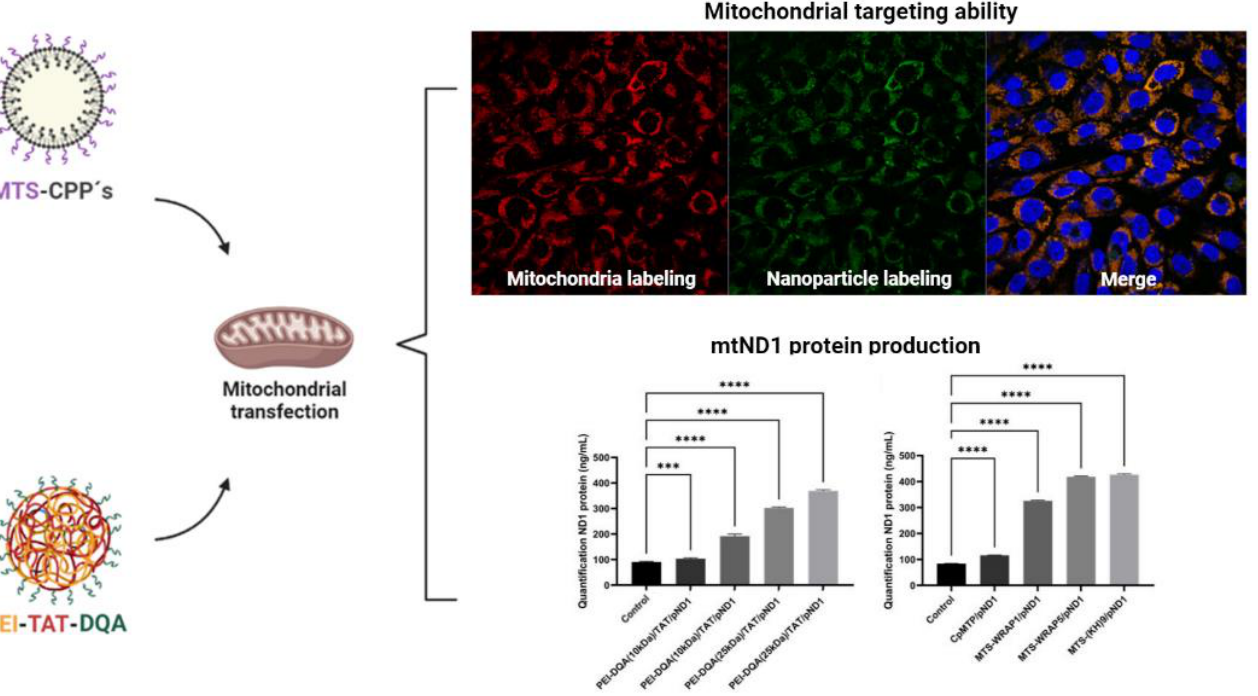
Figure 5. Schematic representation of two strategies/delivery systems developed for mitochondrial gene therapy (MTS-CPPs/pND1 [104] and PEI-TAT-DQA/pND1 [87]) and the most relevant achieved results. The delivery systems demonstrated the ability to target and transfect mitochondria in HeLa cells, a result confirmed by confocal microscopy (Mitochondria were labeled with Mitotracker, the plasmid encapsulated in the systems was labeled with FITC, and nuclei were stained with DAPI). These systems were also able to mediate the delivery of the mitochondrial ND1 gene directly into the mitochondria and the production of the respective protein after transfection of HeLa cells, an achievement demonstrated by the quantification of ND1 using the Elisa kit. Data were analyzed by one-way ANOVA. Data analysis was conducted with GraphPad Prism v.8.01 (GraphPad Software, Inc., San Diego, CA, USA). A p -value below 0.05 was considered statistically significant; *** p < 0.001 and **** p < 0.0001. The images of the results were adapted from [87,104]. Schematic representation created at BioRender.com.